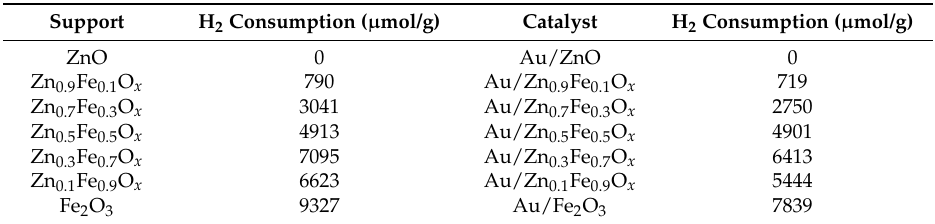
Table 1. H 2 consumption amount in TPR experiments from 50 to 800 °C. Support